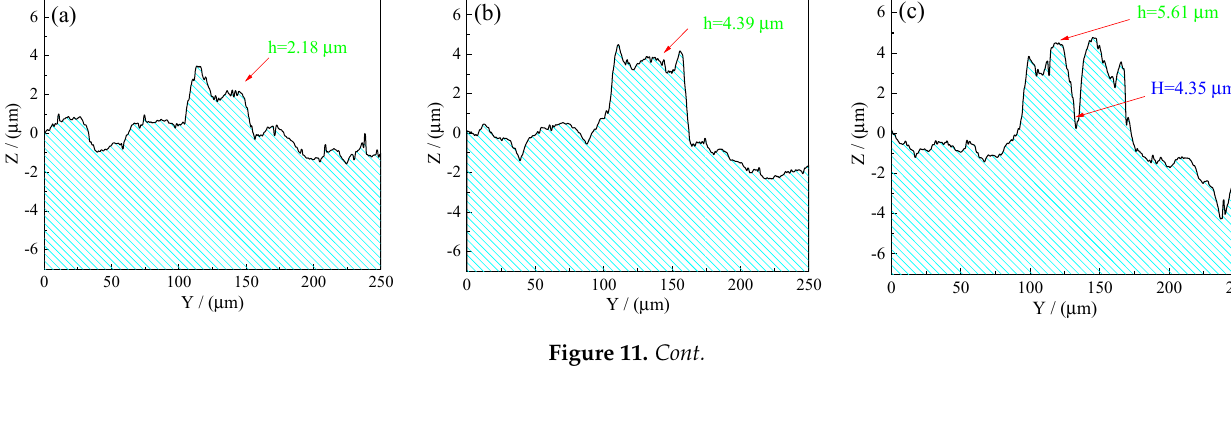
h=3.53 μ m H=7.65 μ m Figure 11. Experimental 2D cross-sectional profiles obtained from Figure 10: ( a ) 75 µs, 50 W; ( b ) 100 µs, 50 W; ( c ) 125 µs, 50 W; ( d ) 150 µs, 50 W; ( e ) 75 µs, 60 W; ( f ) 100 µs, 60 W; ( g ) 125 µs, 60 W; ( h ) 150 µs, 60 W. The above phenomena may be associated with the Marangoni effect driven by a sur- face tension gradient. The time required for the samples’ surface temperature to reach the melting point may decrease with the rise in pulse width. The molten liquid flowed out- ward from the center of the created convex dome to the edge, which formed the small dimple on the center of the created convex dome. According to Wang et al. [20], the diam- eter and height of the created convex dome became larger with increasing laser power. In